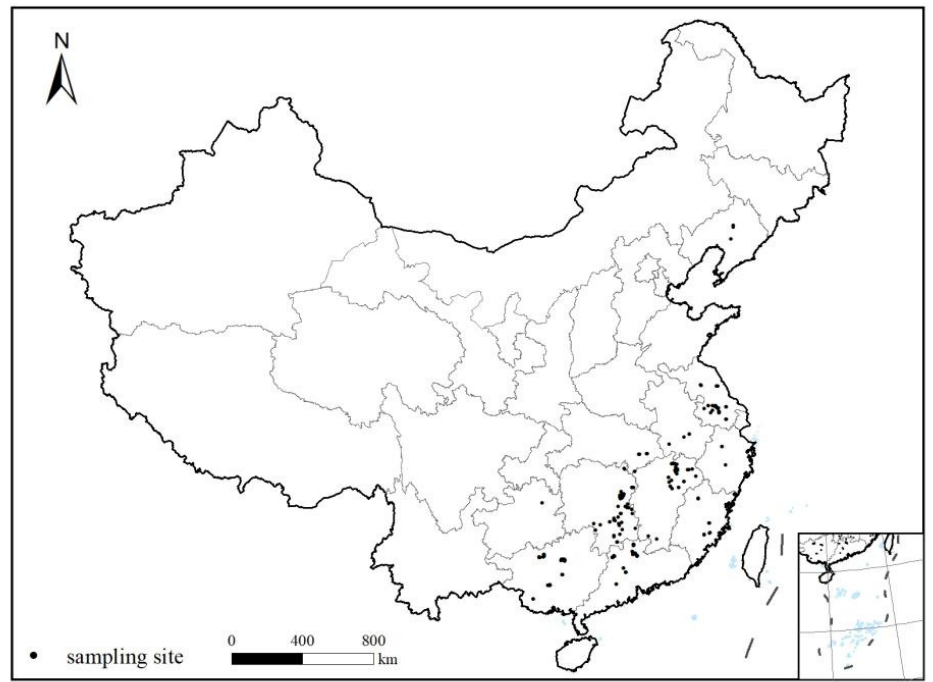
Figure 1. Spatial distribution of soil–rice grain sampling sites in China.